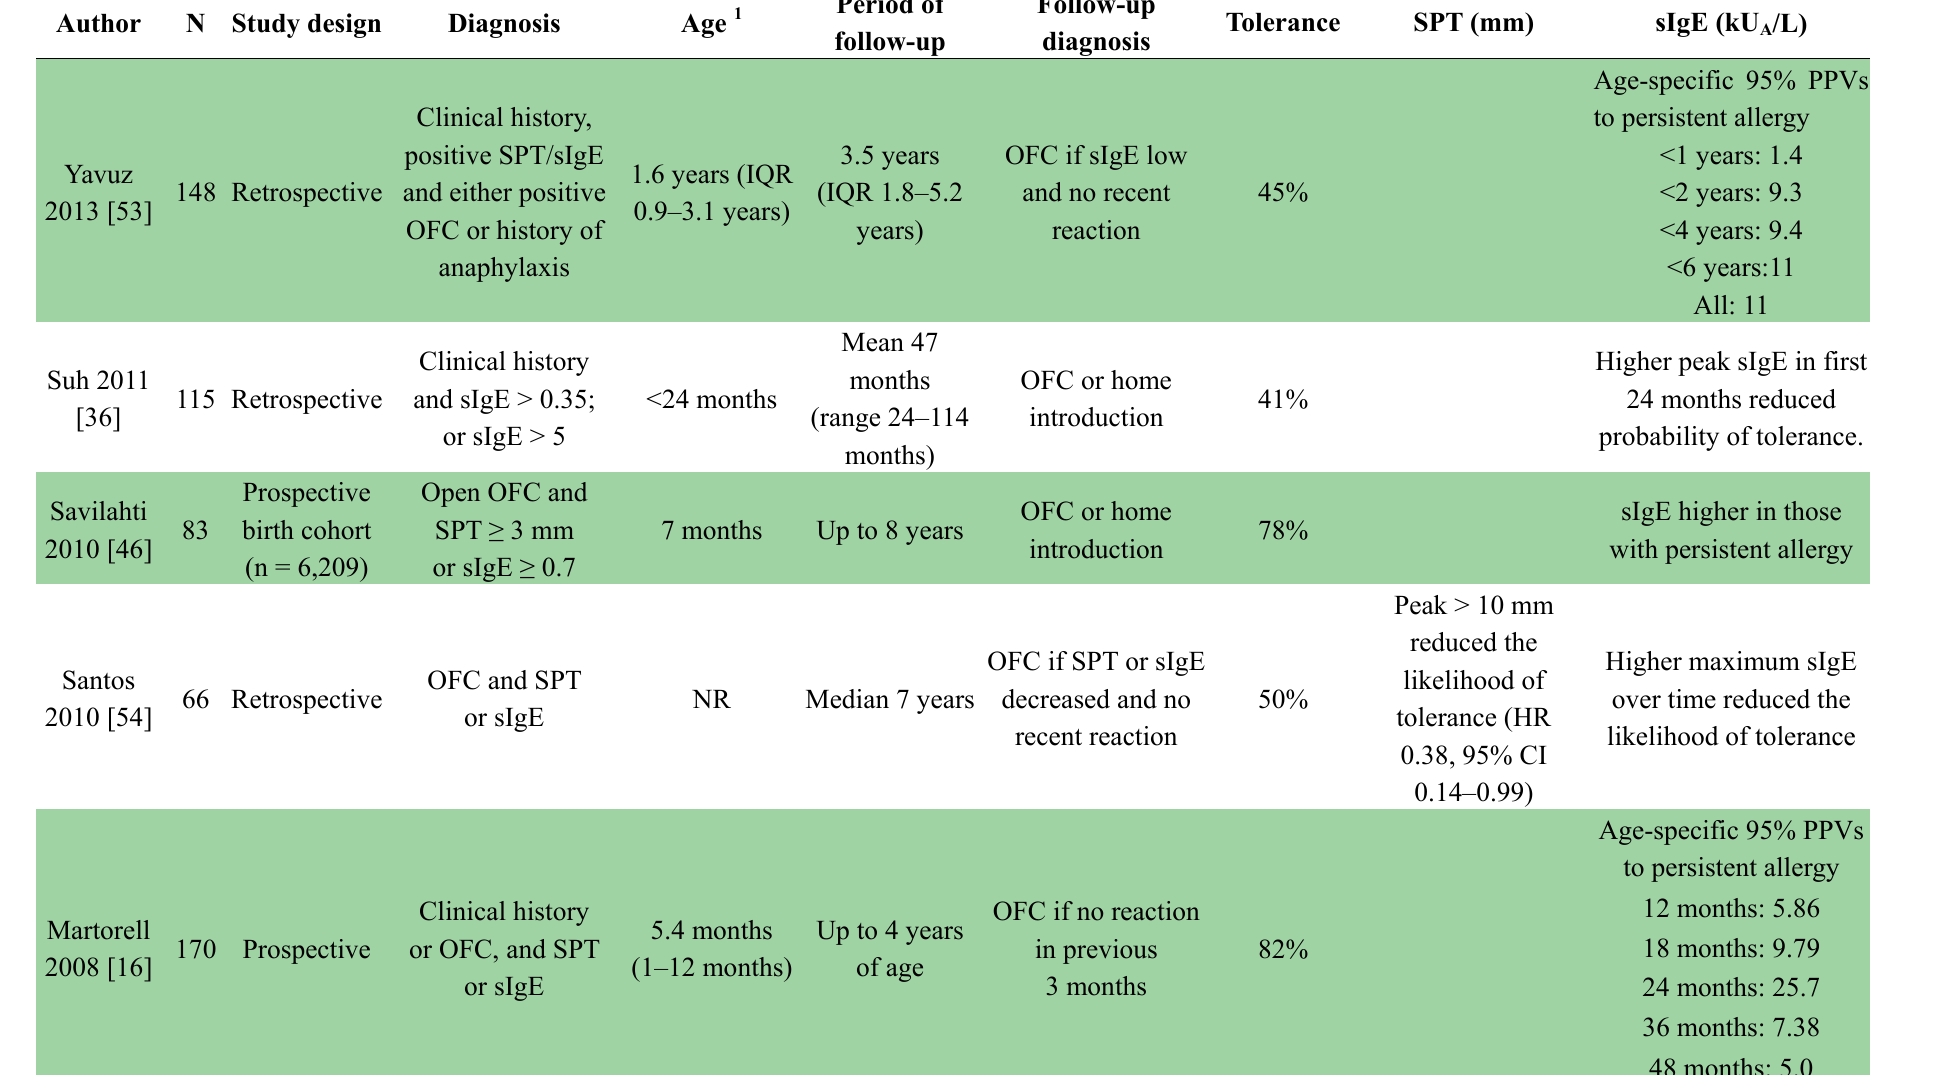
Table 3. Studies reporting on sIgE as a predictor of the prognosis of MILK